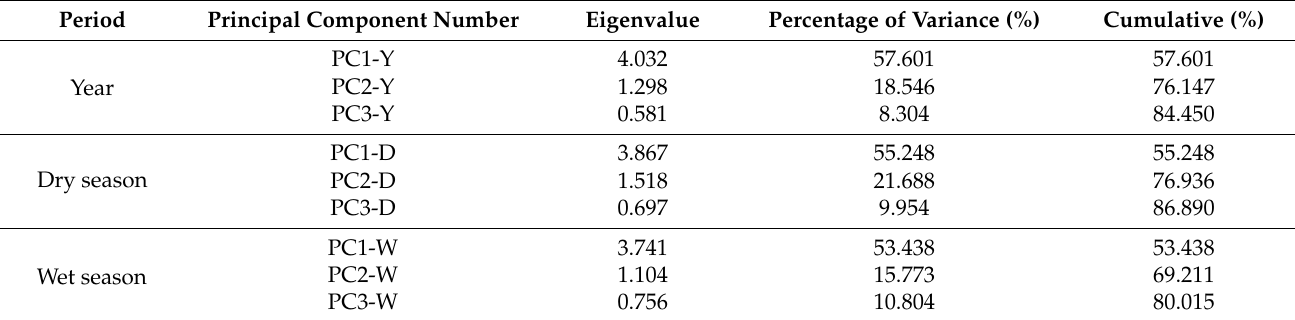
Table 4. Eigenvalue and principal component contribution rate.